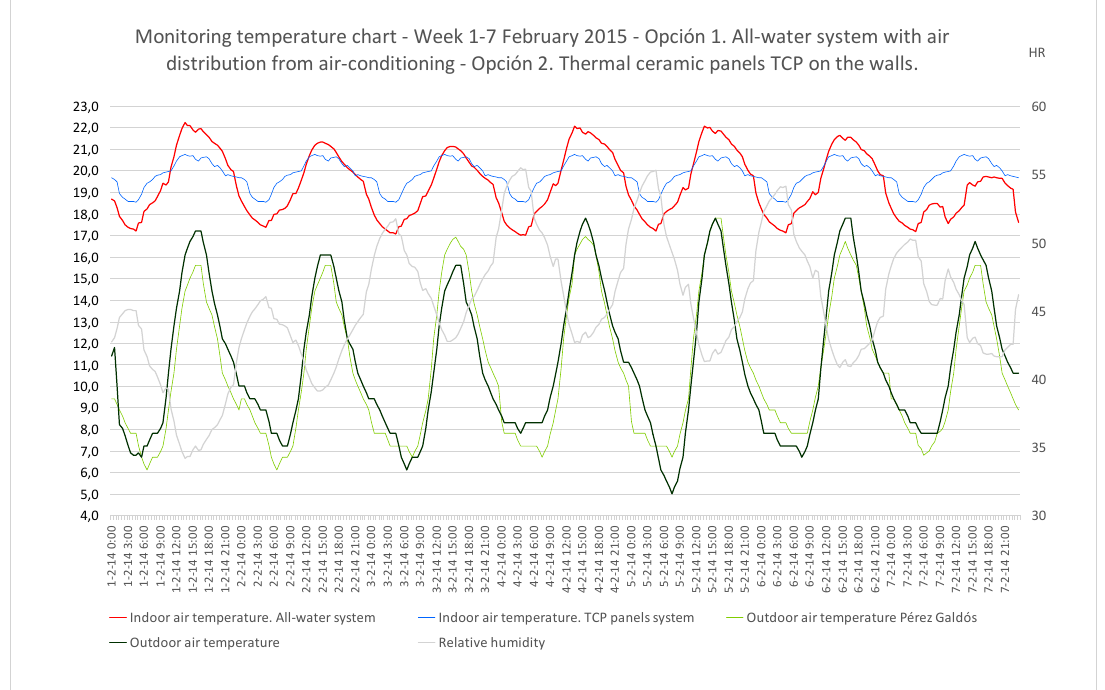
Figure 17. The parameters of outdoor and indoor air during a winter week.